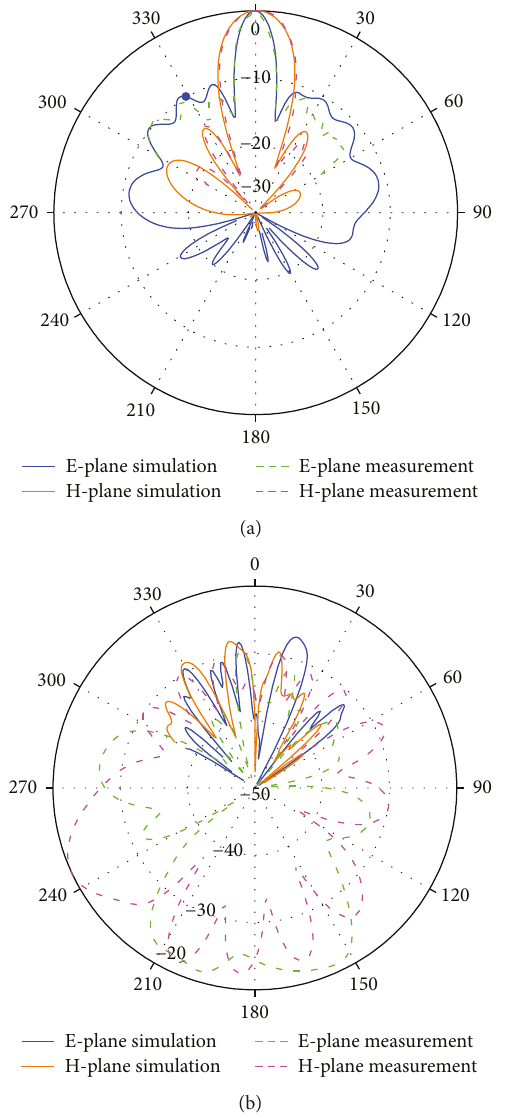
Figure 9: The simulated and measured radiation patterns at 27.6GHz. (a) Coplanar polarization. (b) Cross